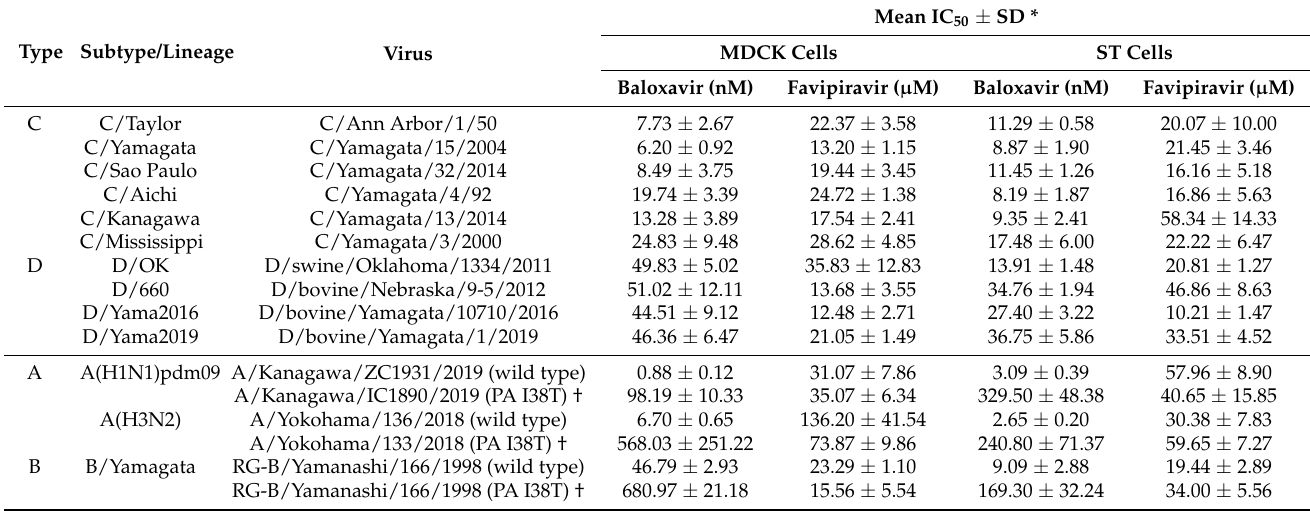
Table 1. Susceptibilities of influenza C and D viruses to RNA polymerase